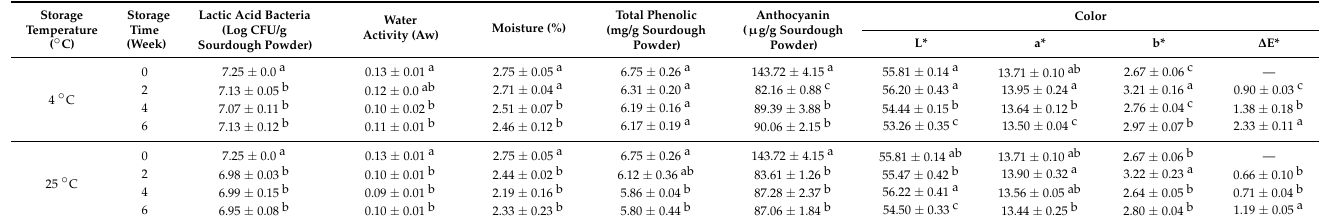
Table 3. The content of lactic acid bacteria, moisture, water activity, total phenols, total anthocyanins, and color change of Type III black rice sourdough flour during